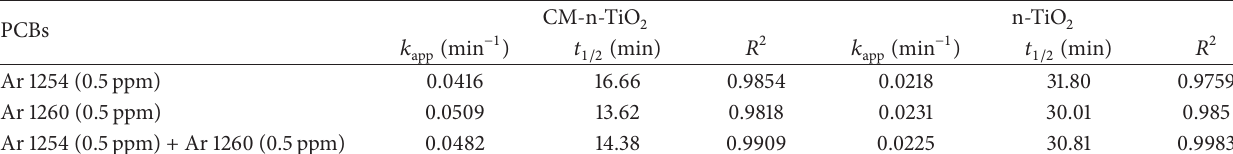
Table 2: Apparent rate constants ( 𝑘 app ) and half-life time reaction ( 𝑡 1/2 ) for the photocatalytic degradation of PCBs in seawater using the pilot plant (SFFR).